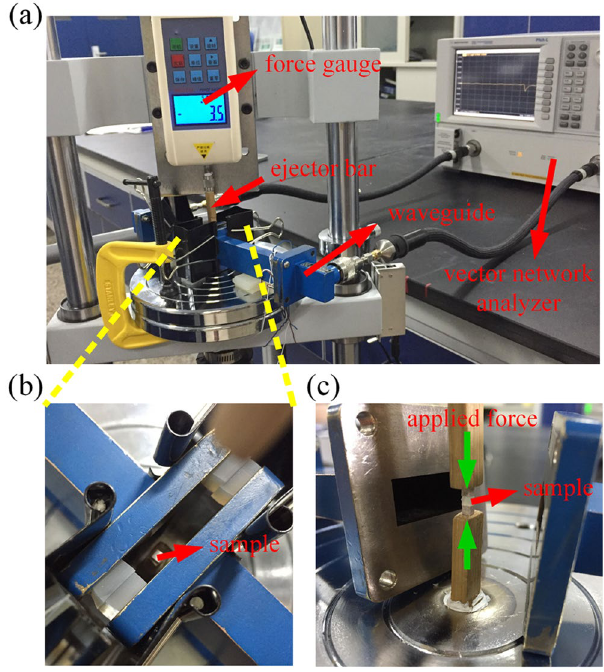
Figure 3. ( a ) An overview of the experiment setup. ( b ) The sample placed on the wood ejector bar. ( c ) The compressive force applied on the sensor orthogonally by the ejector bars.